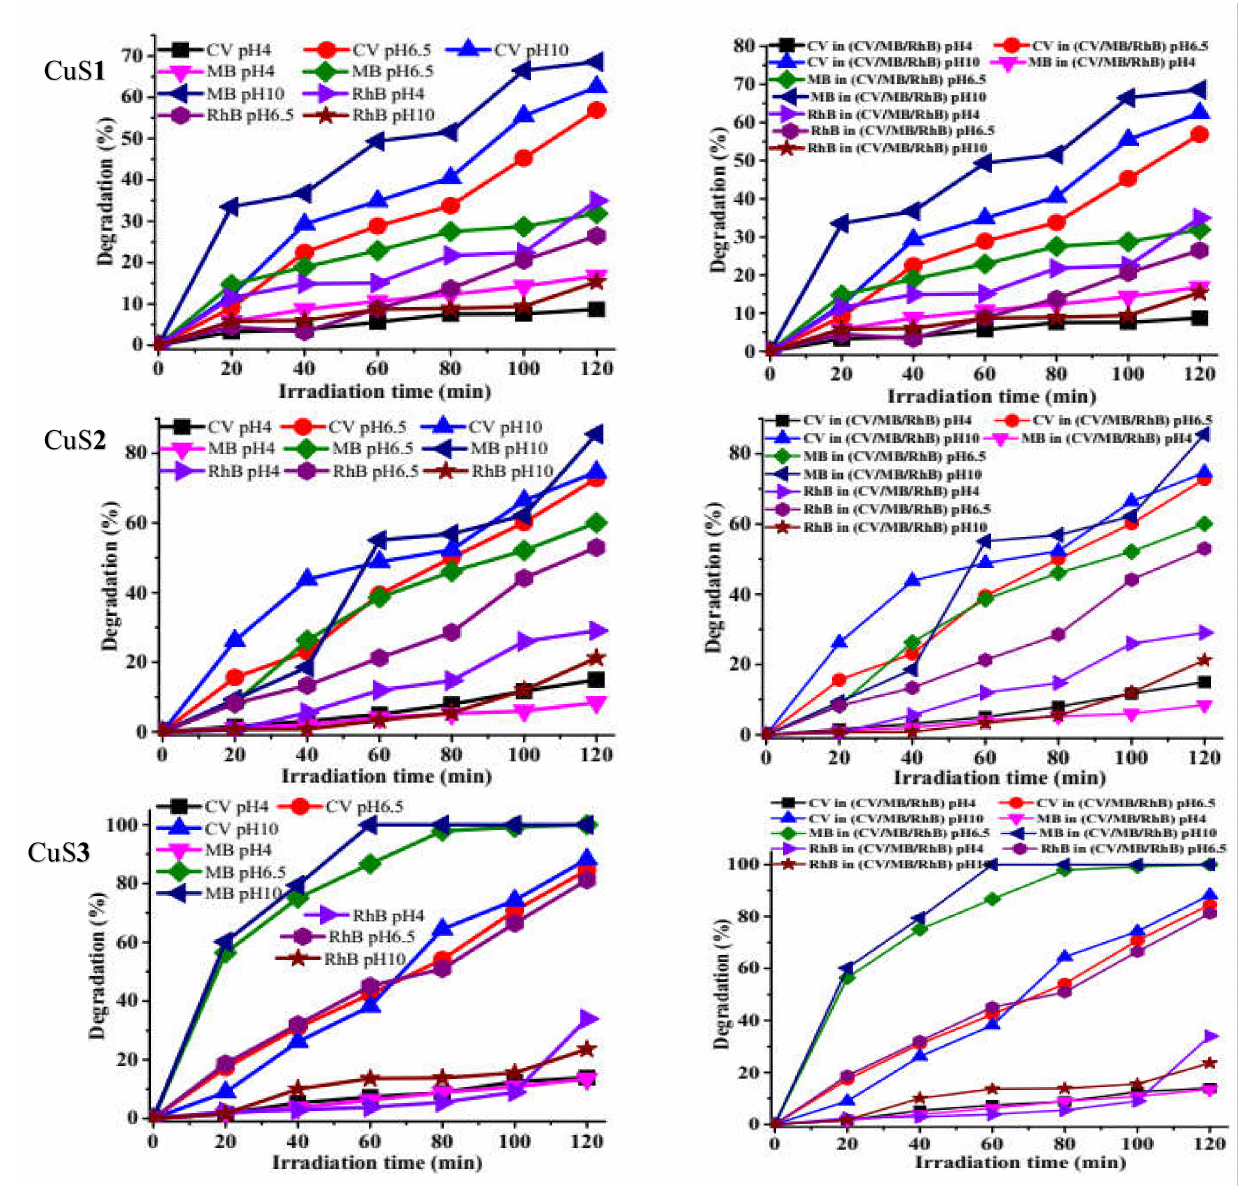
Figure 10. Effect of pH on single dye and corresponding ternary dye solution over CuS